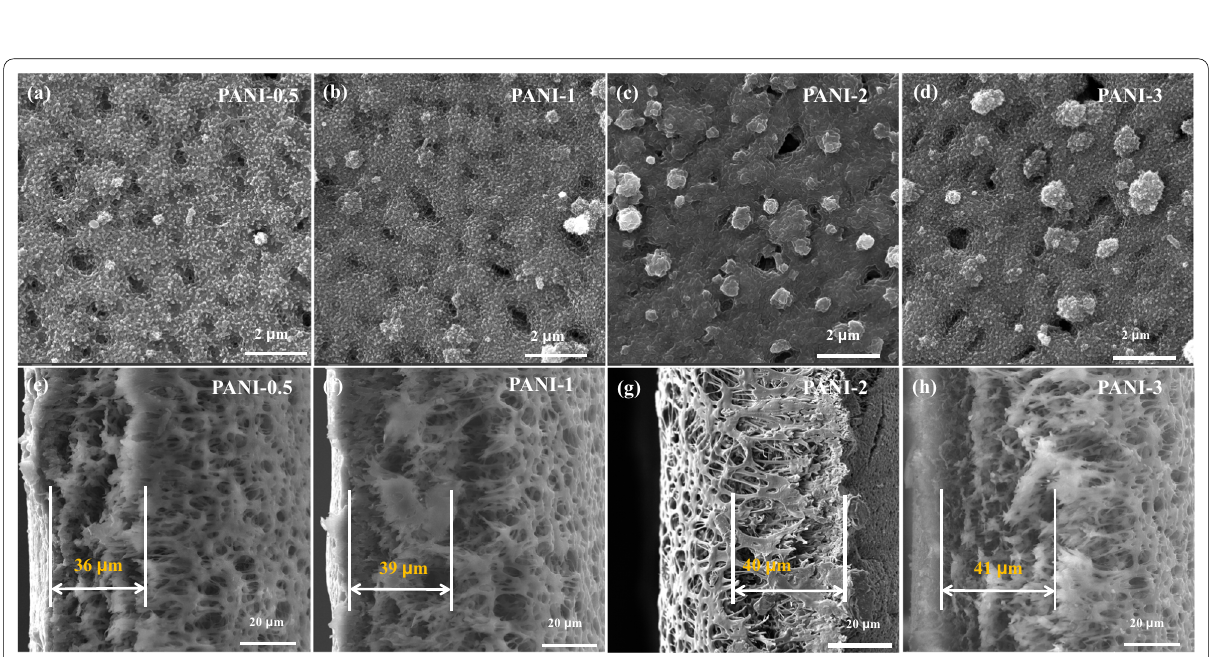
Fig. 3 SEM images of surface on a PANI-0.5, b PANI-1, c PANI-2, d PANI-3 porous films, and cross sections of e PANI-0.5, f PANI-1, g PANI-2, h PANI-3 porous